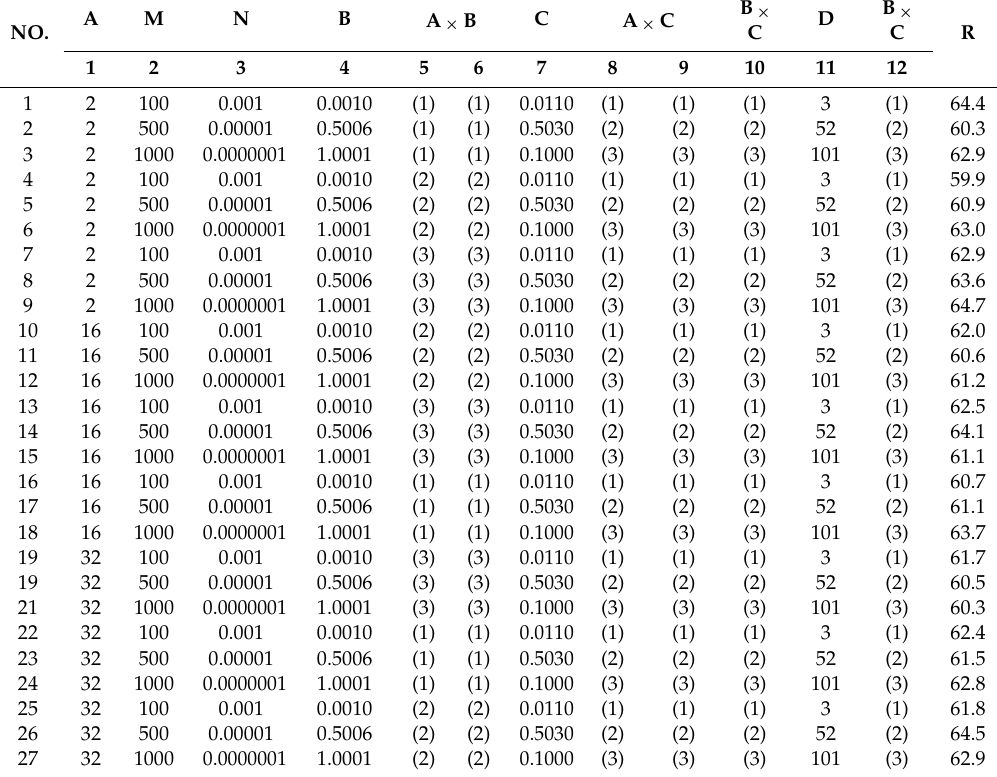
Table 10. The sample deviation analysis results of each interaction